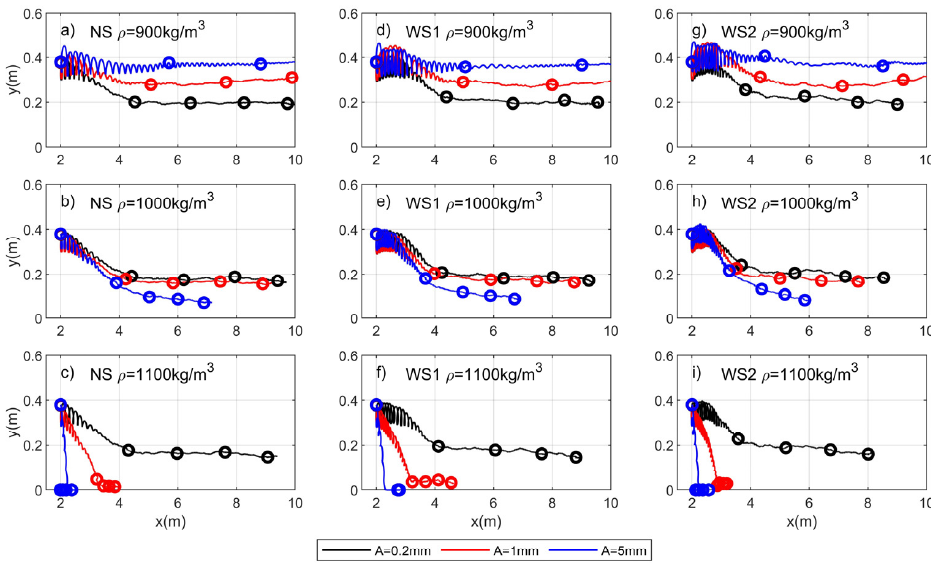
Figure 6. Mean trajectories of 500 particles released at (x, y) = (2, 0.38) m. The circles indicate the mean locations every 20 s.